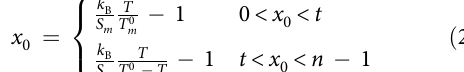
¼ H (cid:2) TS is the e e e